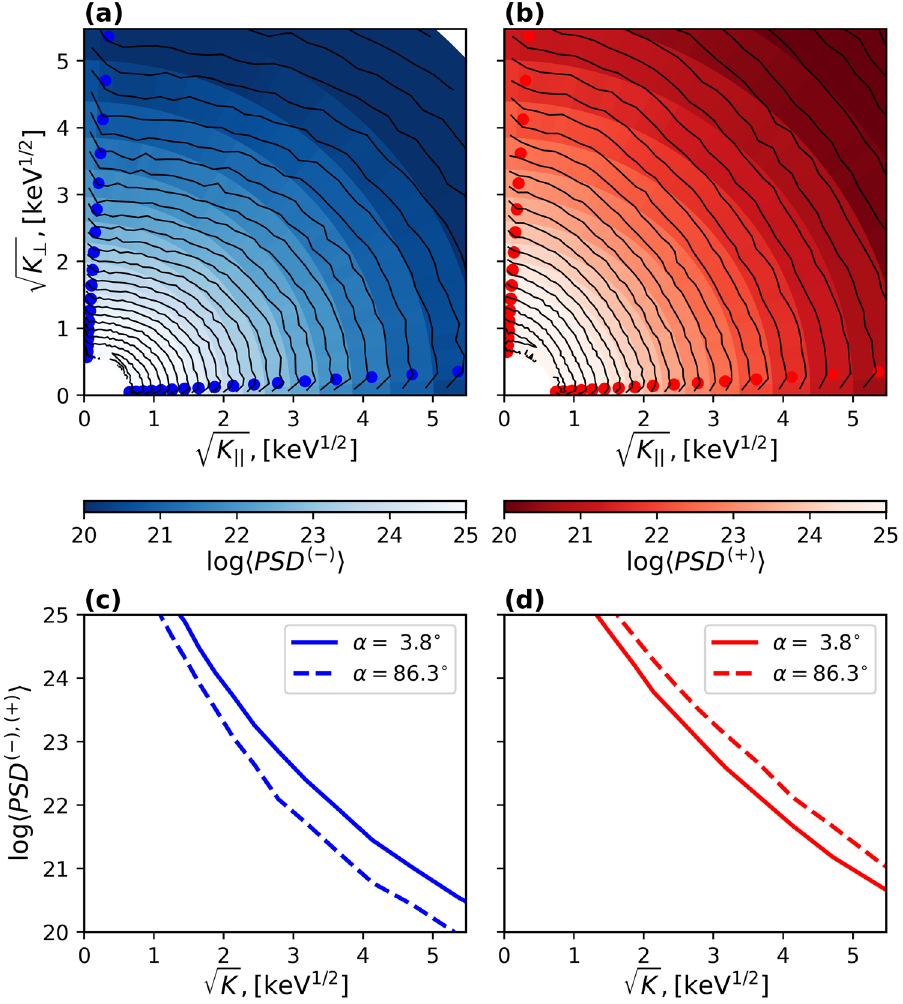
Figure 3. The parallel (panels ( a ) and ( c )) and perpendicular (right panels ( b ) and ( d )) anisotropies in electron distributions around dipolarization flows have similar values over the entire electron energy range. Panels ( a ) and ( b ) show electron PSD, averaged over the regions of parallel and perpendicular anisotropies shown in Fig. 2. The line plots in panels ( c ) and ( d ) show cuts of electron PSD at small and large pitch-angle values (indicated with symbols in panels ( a ) and ( b